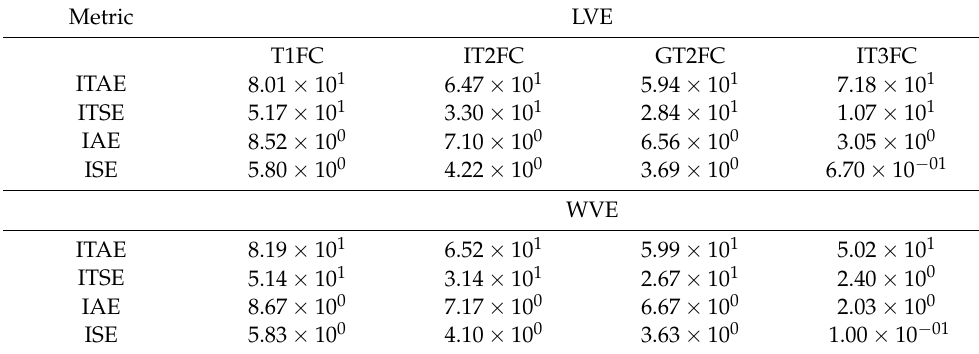
Table 10. Metric results with